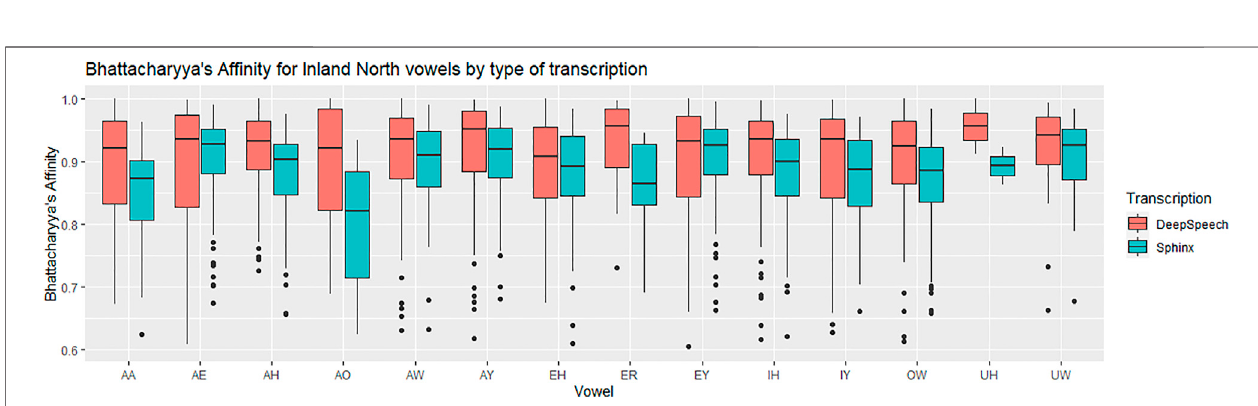
FIGURE 10 | Inland North: vowel medians for the Bhattacharyya ’ s af fi nity by type of transcription. Red: DeepSpeech versus ground truth, Green (cid:1) CMU Sphinx versus ground truth. 58 speakers and a total of 14,414 vowel